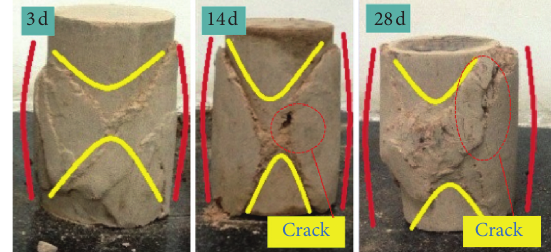
Figure 24: Appearances of stabilized soils after failure.